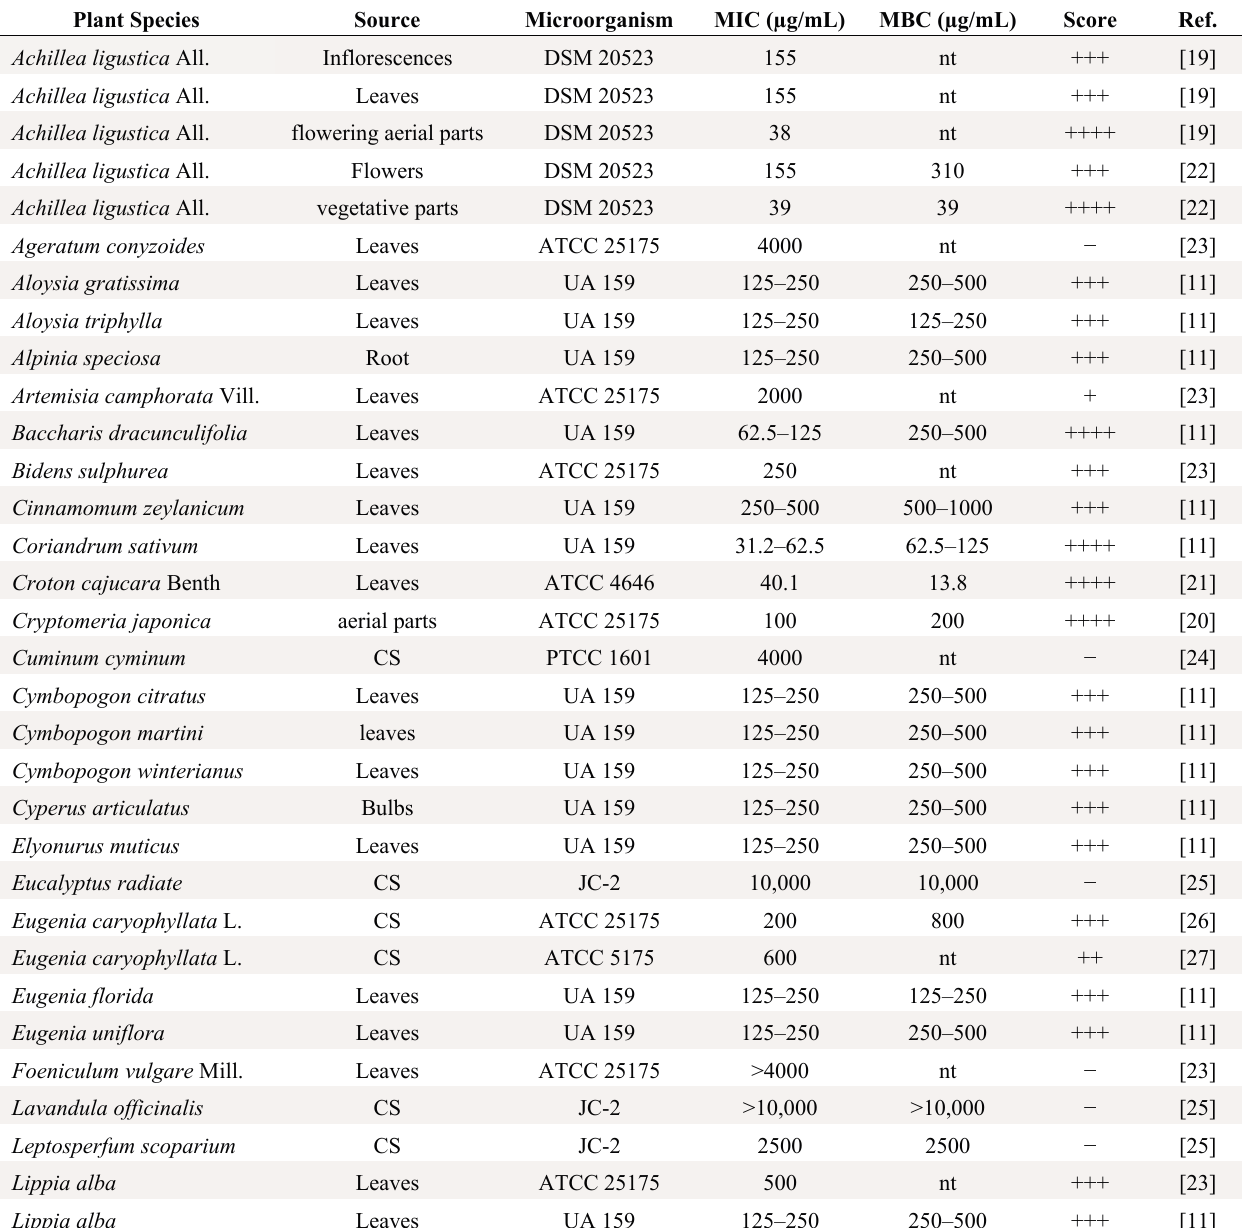
Table 1. In vitro antibacterial activity of essential oils against Streptococcus